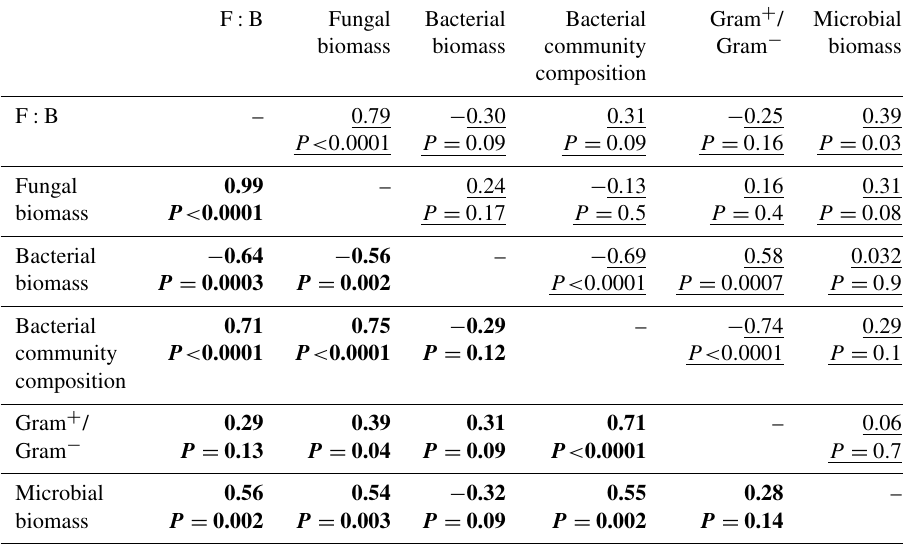
Table A1. Correlation matrix among descriptors of microbial community. Spearman’s correlation coefficients ( ρ ) for the bacterial-based system (underlined) and the fungal-based system (in bold).